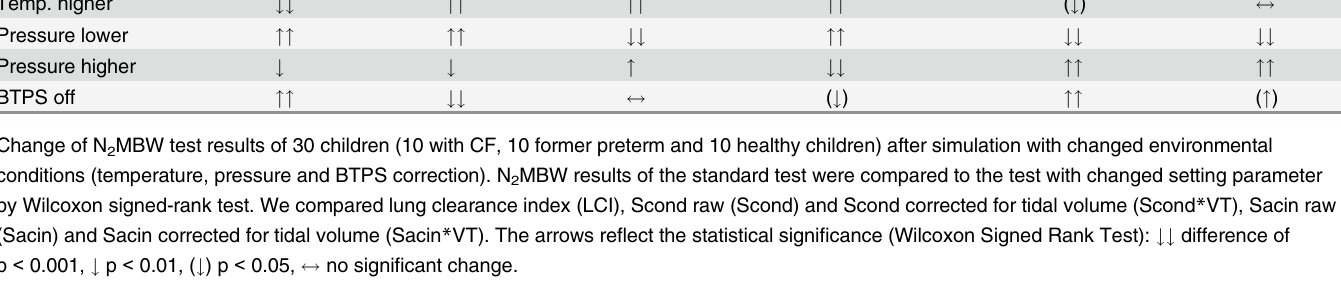
and FRC (Table 4). Vice versa increased dead space decreased LCI and FRC. Mean effect size on LCI was smaller than 2% and lower than 10% in all children (Tables 4 and 5). Interestingly, measurement bias due to dead space changes was strongly non-linearly associated with FRC, with smaller FRCs being most affected (Fig 3). LCI showed a trend for an analogous but much weaker relationship (data not shown).